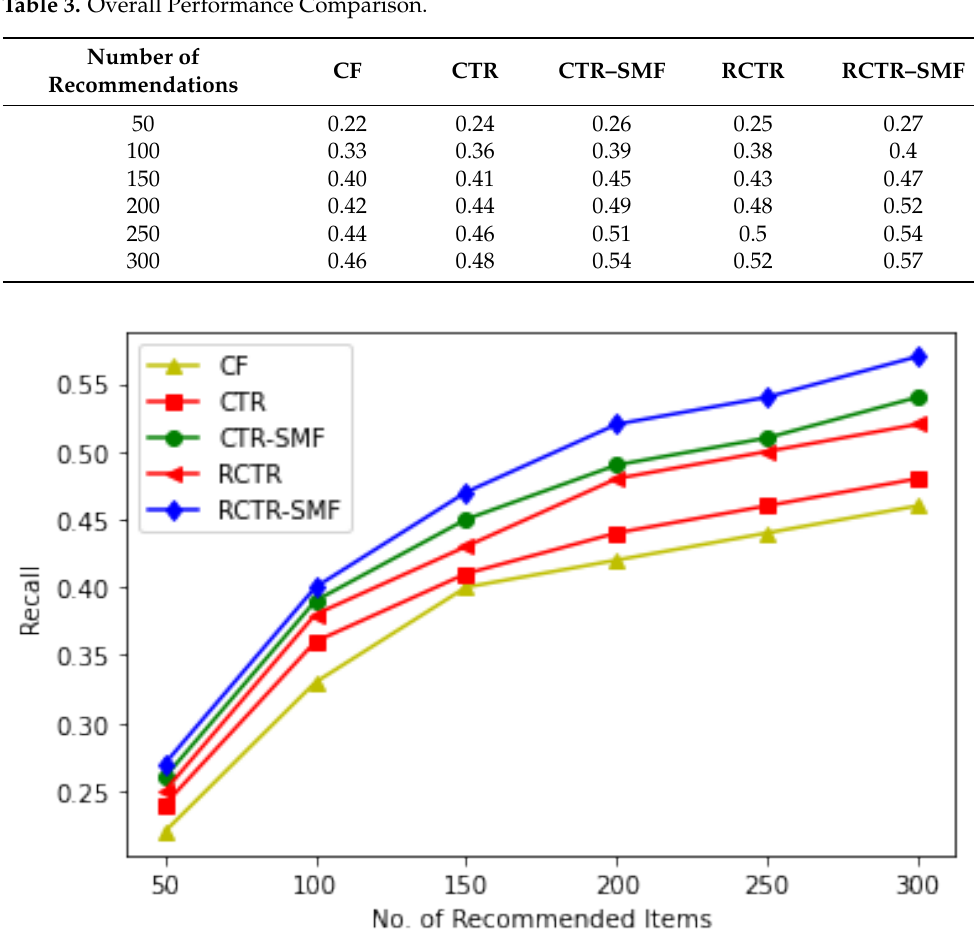
Figure 4. Overall Performance Comparison in terms of Recall and Number of Recommendations.